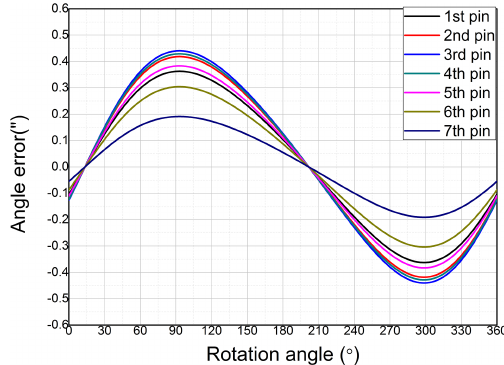
Figure 8. Angle error due to torsional deformation (equation).